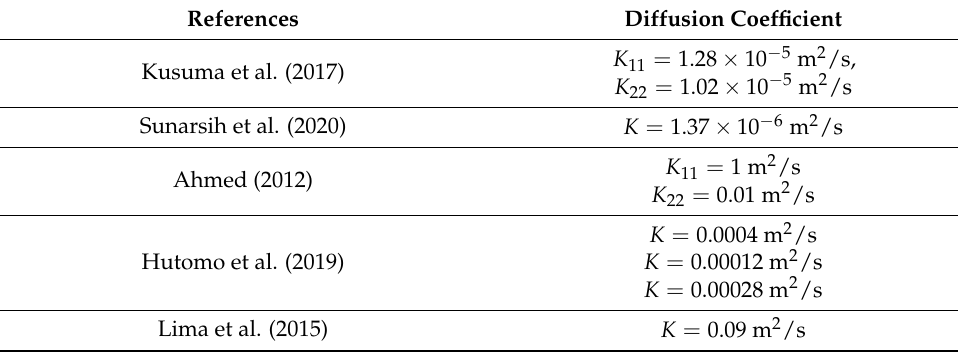
Table 3. Studies with different values for the diffusion coefficients